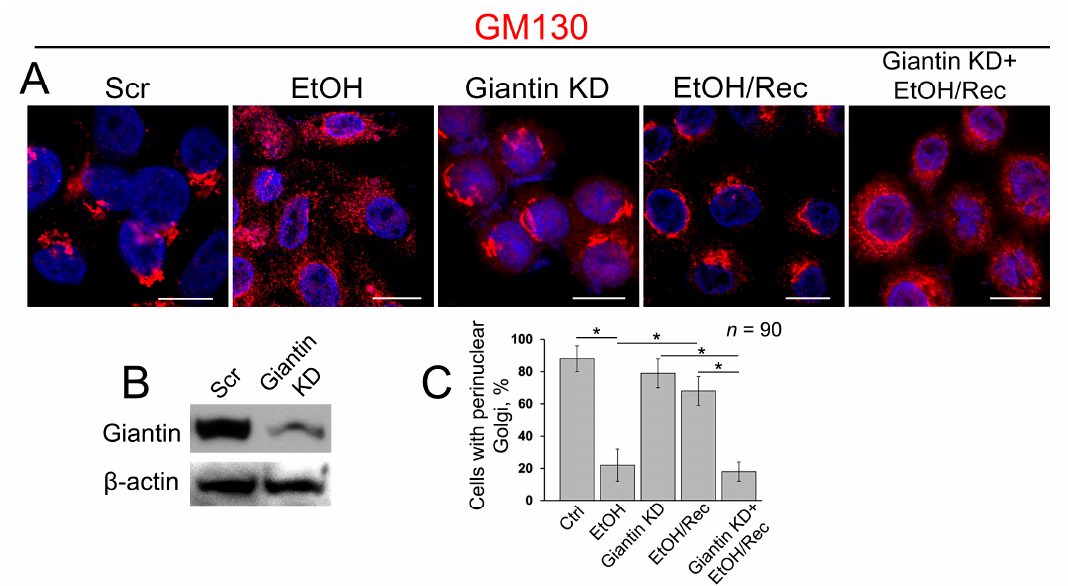
Figure 3. Giantin depletion prevents Golgi restoration in cells recovered from EtOH. ( A ) Confocal immunofluorescence images of Golgi (GM130) in VA-13 cells: treated with scramble small interfering RNAs (siRNA), treated with 35 mM EtOH for 72 h, giantin siRNAs, EtOH-treated followed by recovery for 48 h, or recovered in the presence of giantin siRNAs; bars, 10 µ m; ( B ) Giantin W-B of lysates of VA-13 cells treated with corresponding siRNAs; β -actin was a loading control; ( C ) Quantification of cells with perinuclear Golgi in cells presented in ( A ); n = 90 cells from three independent experiments, results expressed as a mean ± SD; * p < 0.001.